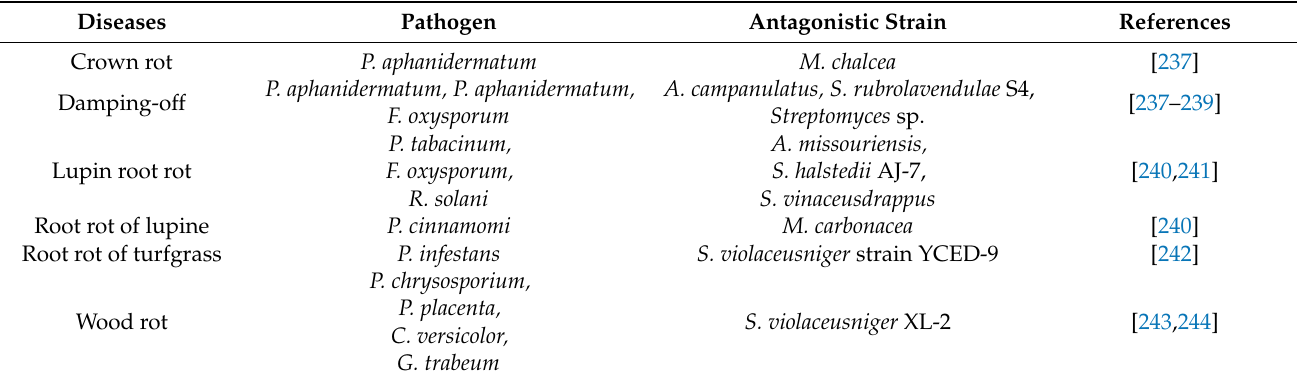
Table 4. Antagonistic actinomycetes suppressing plant